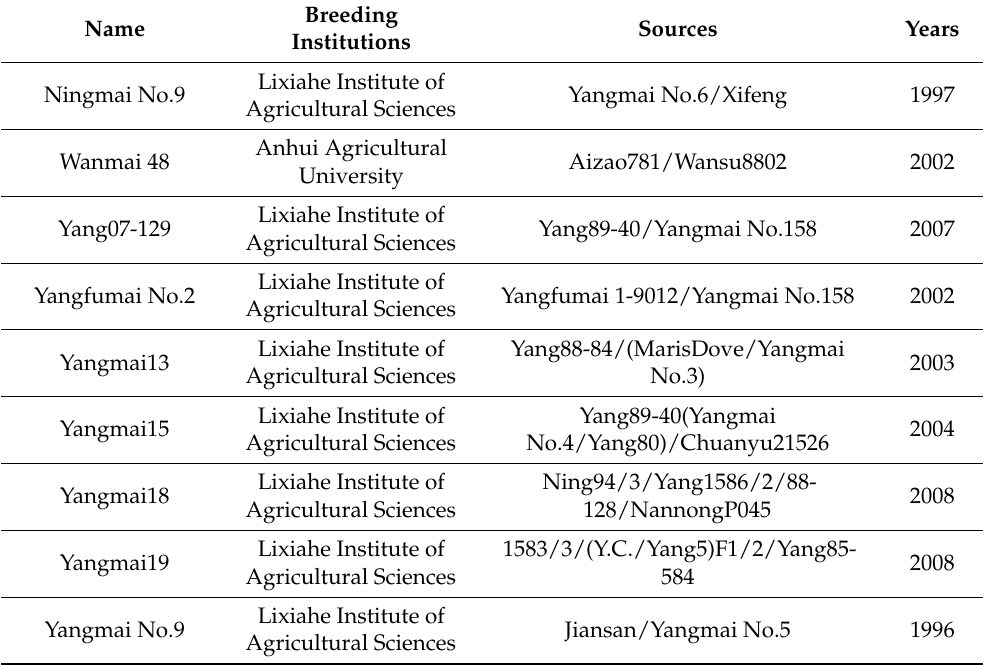
Table 2. Information of the nine weak-gluten wheat